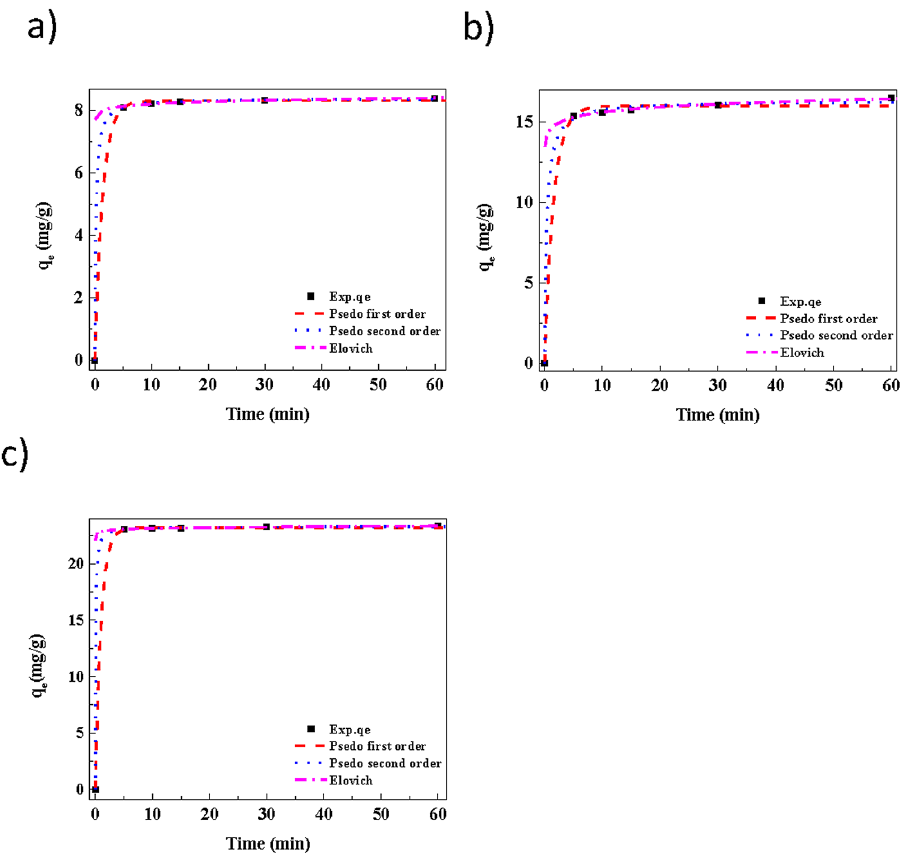
Figure 8. Pseudo-first-order, Pseudo-second-order, and Elovich, models kinetics plots for different concentration: ( a ) 10 mg/L, ( b ) 20 mg/L, ( c ) 30 mg/L. Conditions: As shown in Fig.